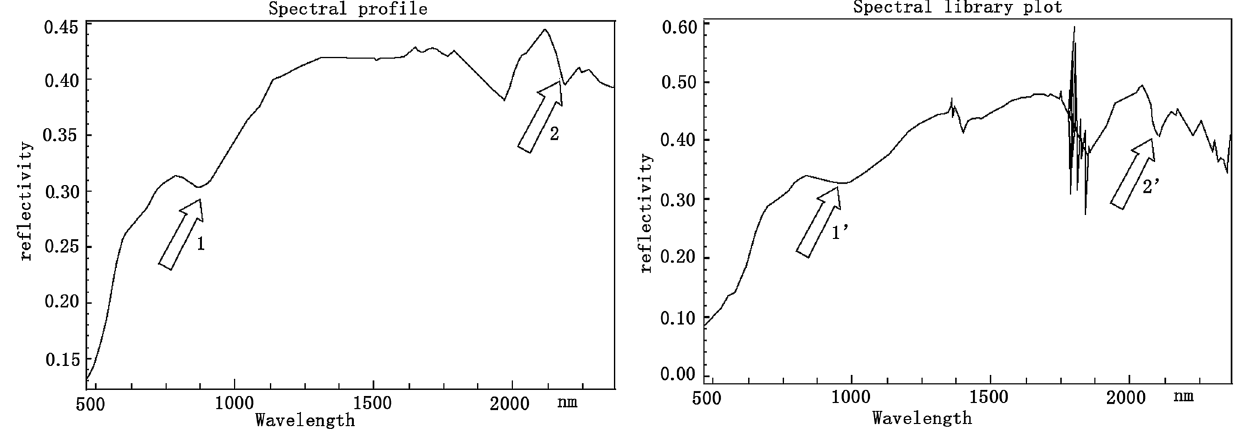
Figure 1. Suspected spectrum (left) of γ 51a collected from the image and field measured spectrum (right). This figure is generated by Yu-Hai Fan, using CorelDRAW X6 created by the CorelDRAW Team under an open license (http://www.corel draw.com/cn/produ ct/graph ic-desig n-softw